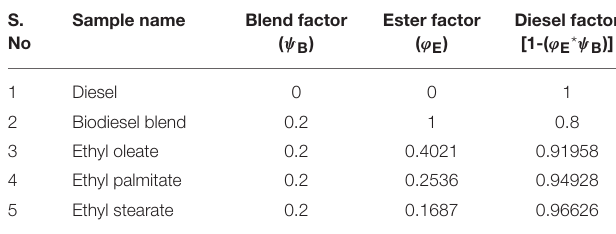
TABLE 3 | Technical Specification of Kirloskar Engine TV1 & AVL DI GAS 444N.